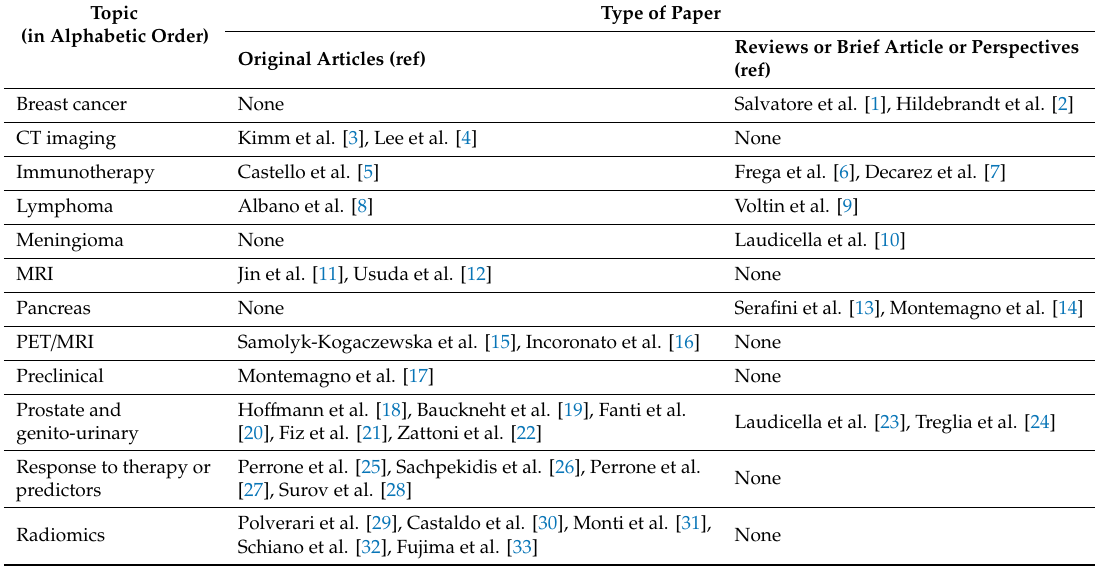
Table 1. Summary of articles in the special